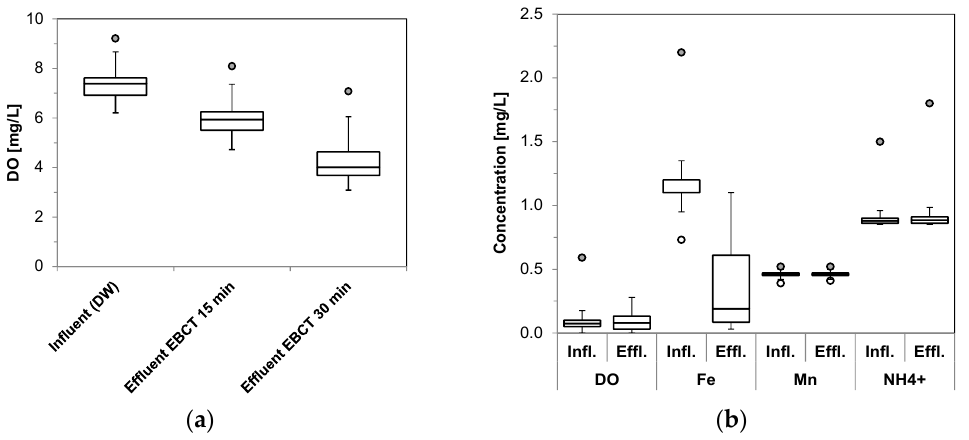
Figure 3. ( a ) Dissolved oxygen concentration in the influent and effluents of two DW-fed fixed-bed adsorbers in series ( n = 49); ( b ) Dissolved oxygen, total iron (Fe), dissolved manganese (Mn), and ammonia (NH4 + ) concentration in the influent and effluent of a GW-fed fixed-bed adsorber ( n = 18–53).